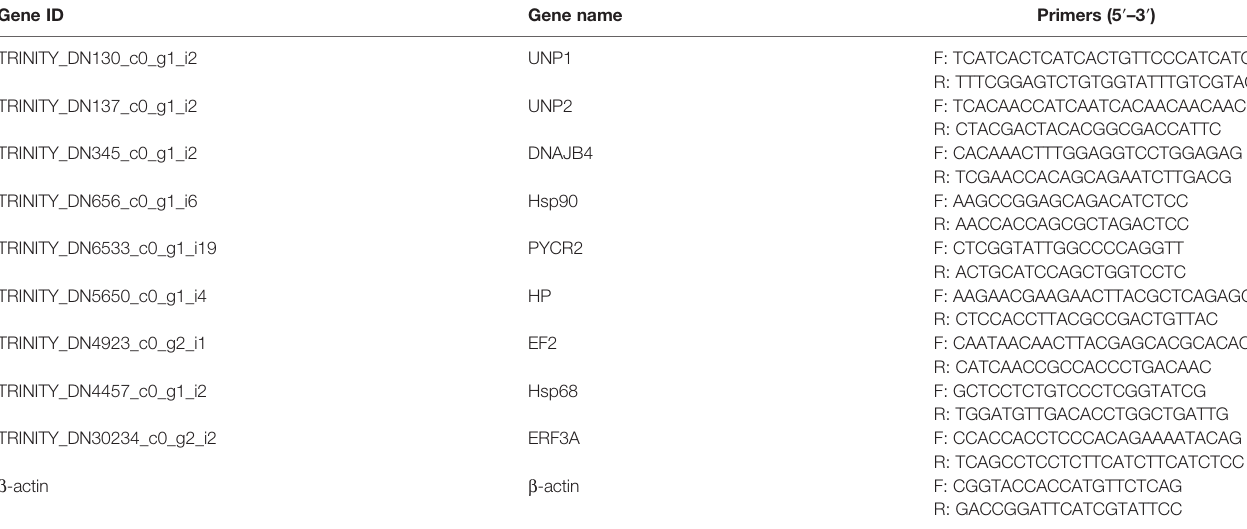
TABLE 1 | Primer sequences of selected genes for quantitative real-time